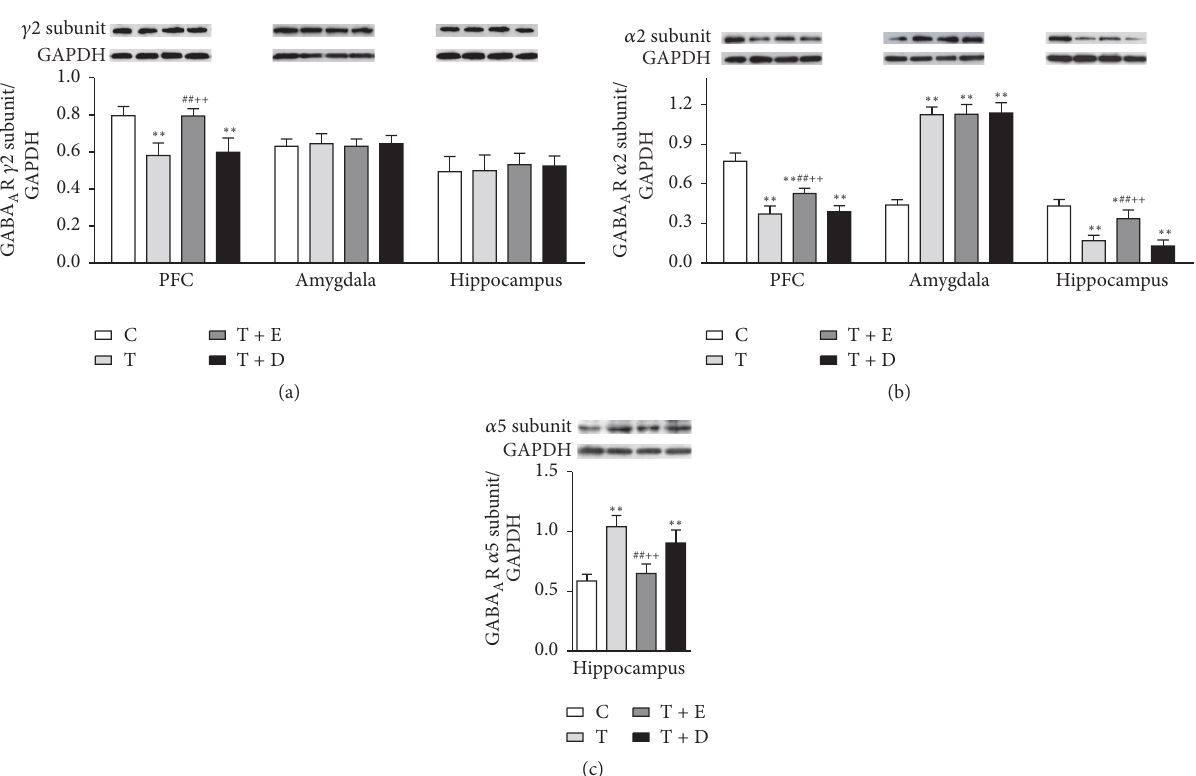
Figure2:GABA Rsubunitsexpressionsinsubregionsofbraininwesternblotting.(a)Theexpressionof 𝛾 2subunitinthePFC,amygdala,and A hippocampus.(b)Theexpressionof 𝛼 2subunitinthePFC,amygdala,andhippocampus.(c)Theexpressionof 𝛼 5subunitinthehippocampus. Values were expressed as mean ± SEM ( 𝑛 = 6 , per group). ∗ 𝑝 < 0.05 and ∗∗ 𝑝 < 0.01 versus C group; ## 𝑝 < 0.01 versus T group; ++ 𝑝 < 0.01 versus T + D